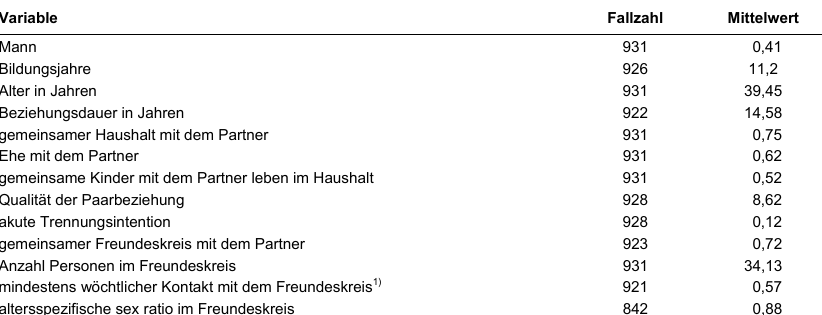
Tabelle 1 : Beschreibung der Stichprobe [b1] Variable Fallzahl